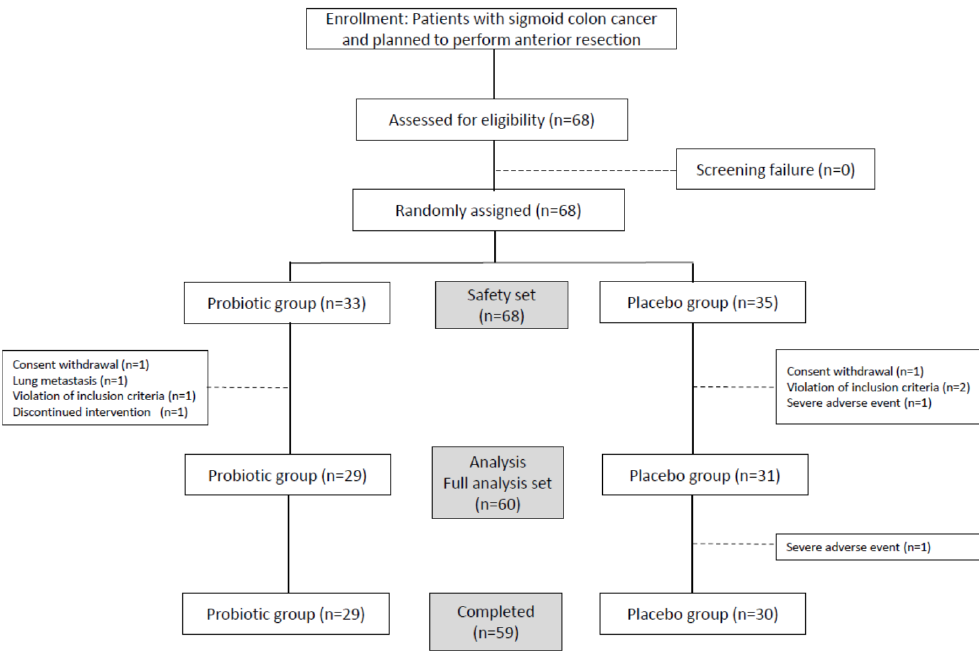
Figure 1. Study design. Consort diagram.